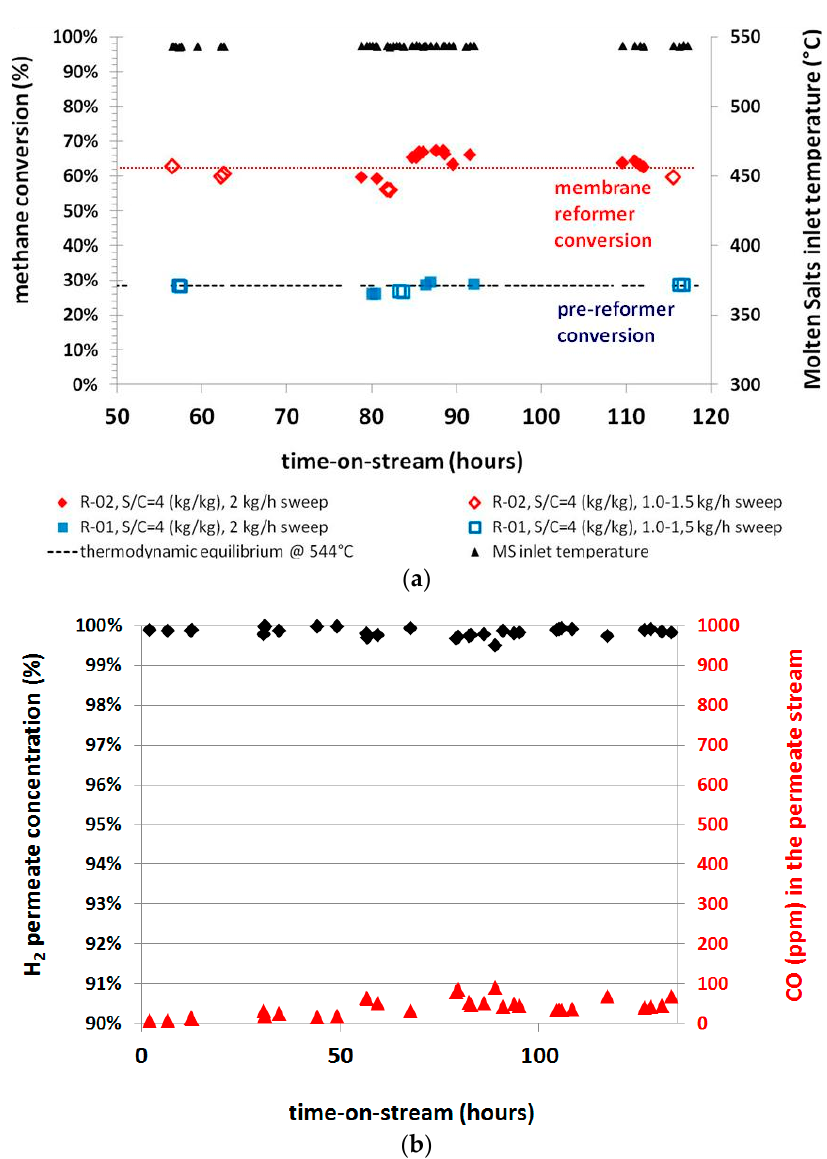
Figure 10. Methane conversion ( a ) and permeate H 2 concentration ( b ) in time-on-stream tests.